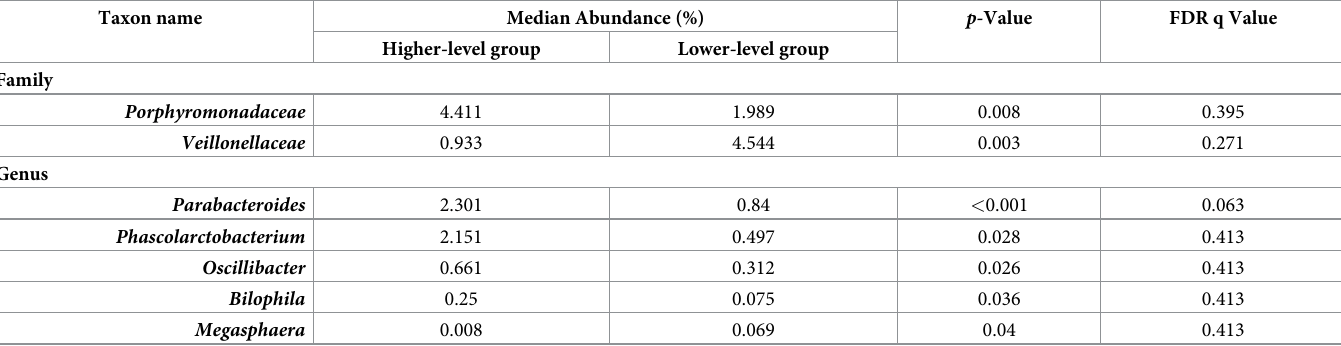
Table 2. Abundant microbial taxa of the faecal samples in the higher-level and the lower-level athletes after adjusting for confounders; only the p -values < 0.05 are shown. Taxon